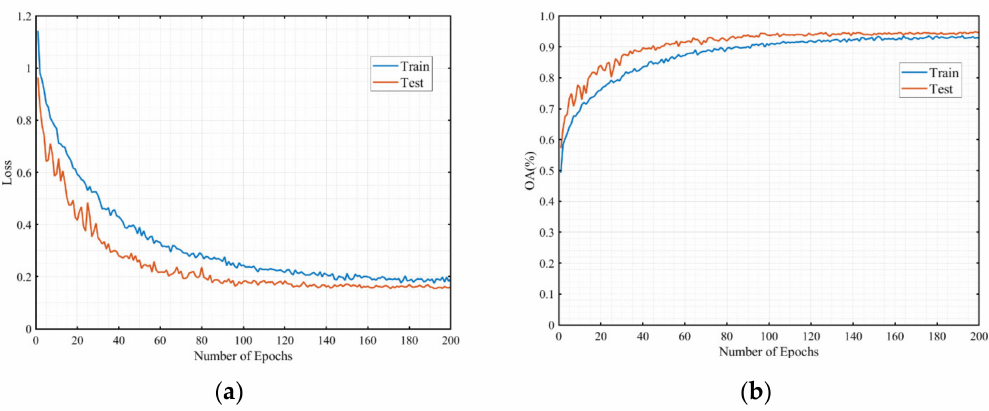
Figure 8. The curves of loss and overall accuracy. ( a ) Loss curve, ( b ) Accuracy curve.